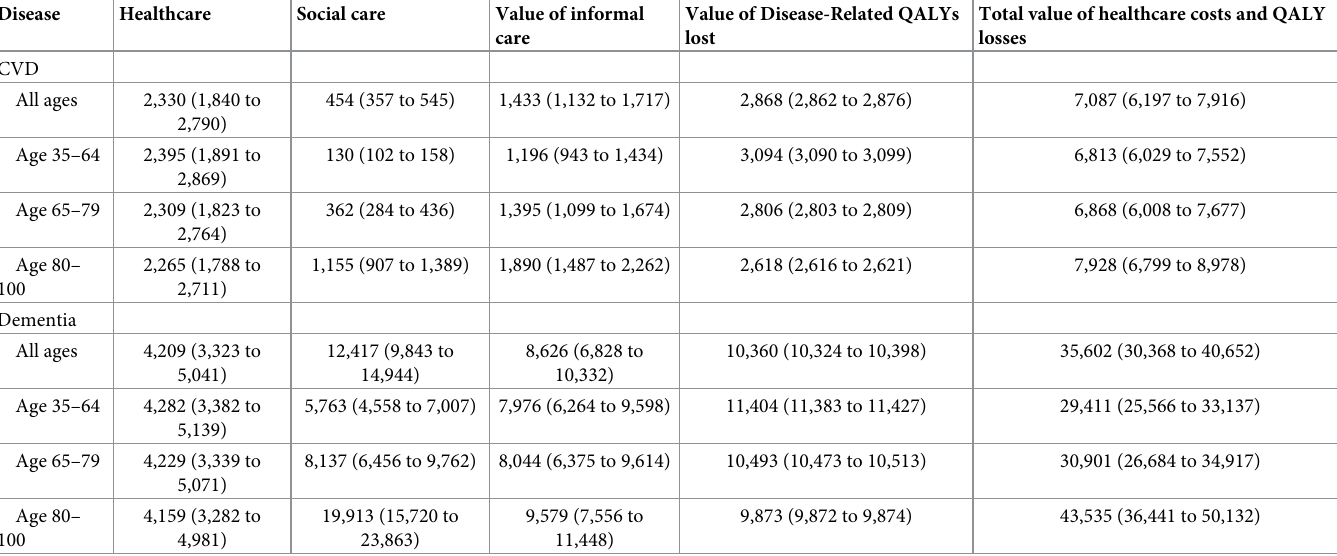
Results shown are from scenario 2 (CVD fall)–however results are broadly similar for both scenarios. Note some people have both CVD and